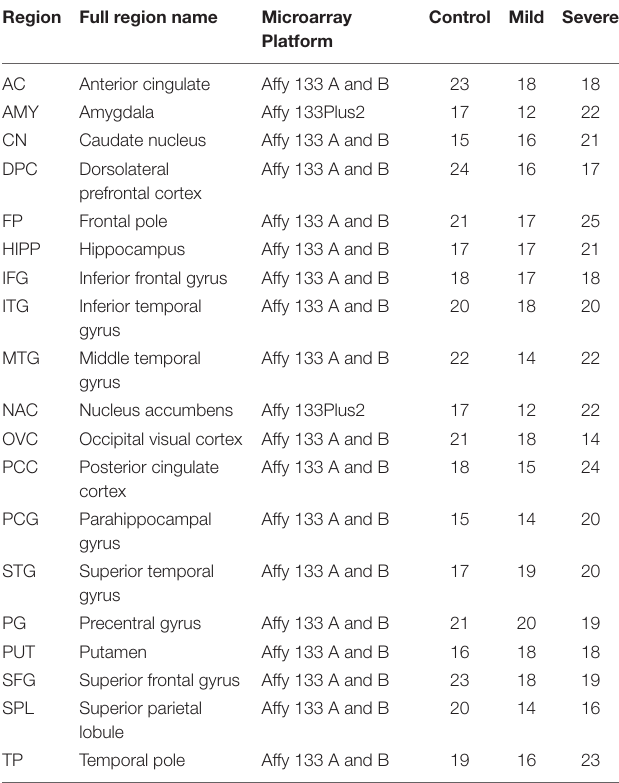
TABLE 1 | Brain regions and disease groups information of samples used in co-expression